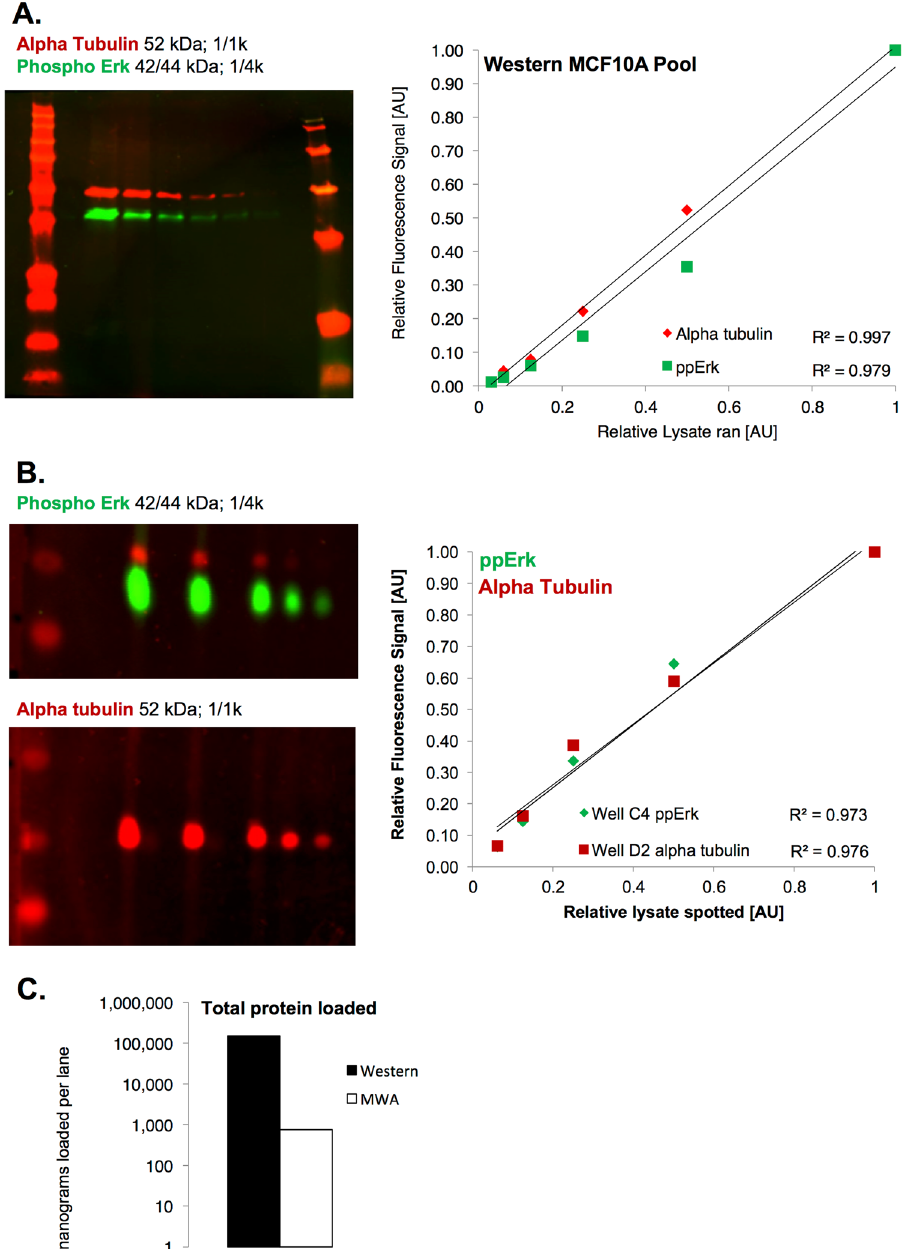
Figure 5. Comparison of Western to Microwestern. Lysates from exponentially growing MCF10A cells were used for these experiments. ( A ) Measurement of ppERK1/2 and alpha-tubulin using a “regular” Western with quantification results. ( B ) Measurement of ppERK1/2 and alpha-tubulin using a microwestern at matched antibody dilution conditions with the same cell systems. Cropped image of Well C4 (see Supplemental Information, Fig. S4 for full scan) used to measure ppERK1/2. Cropped image of Well D2 (see same full scan) used to measure alpha-tubulin. ( C ) Total protein loaded per well is significantly lower for a MWA. Note the log y-axis